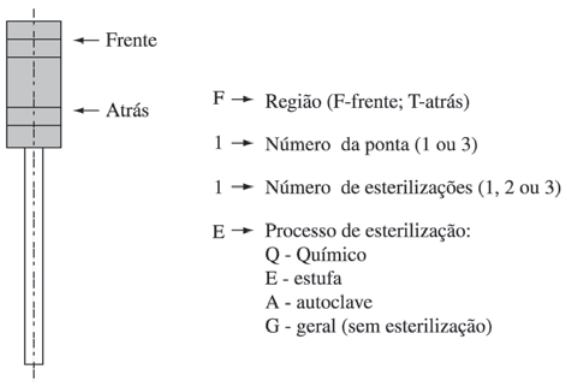
Figura 2. Nomenclatura das pontas diamantadas para os